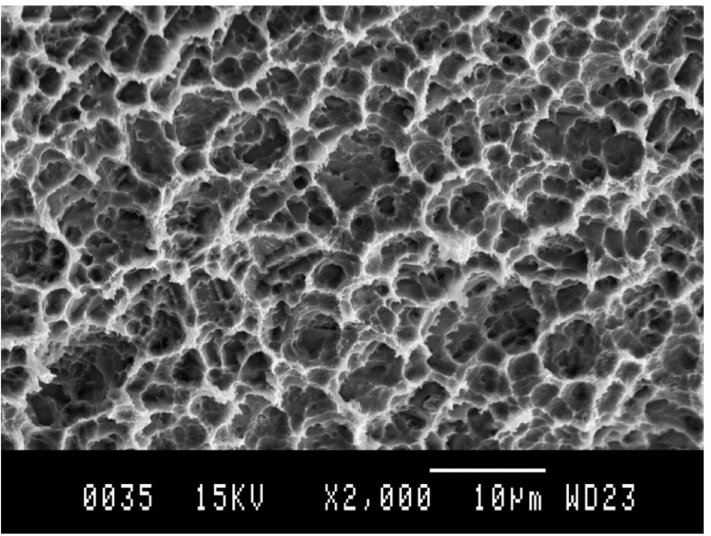
Figure 14. Surface of the SLAactive